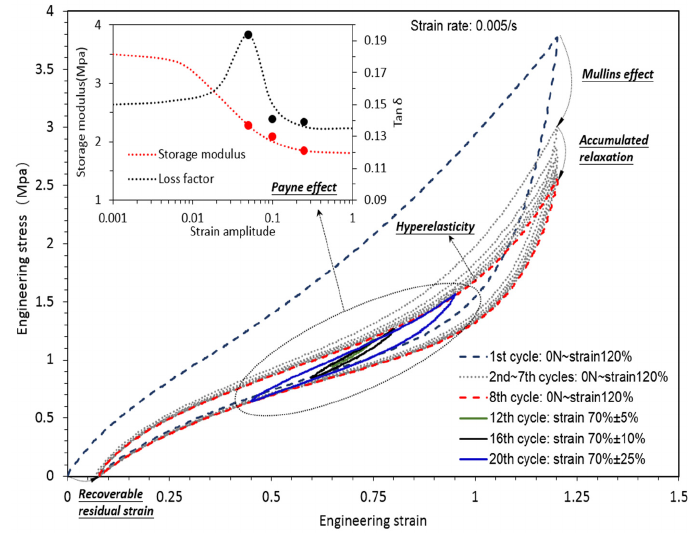
Figure 2. Inelasticity of